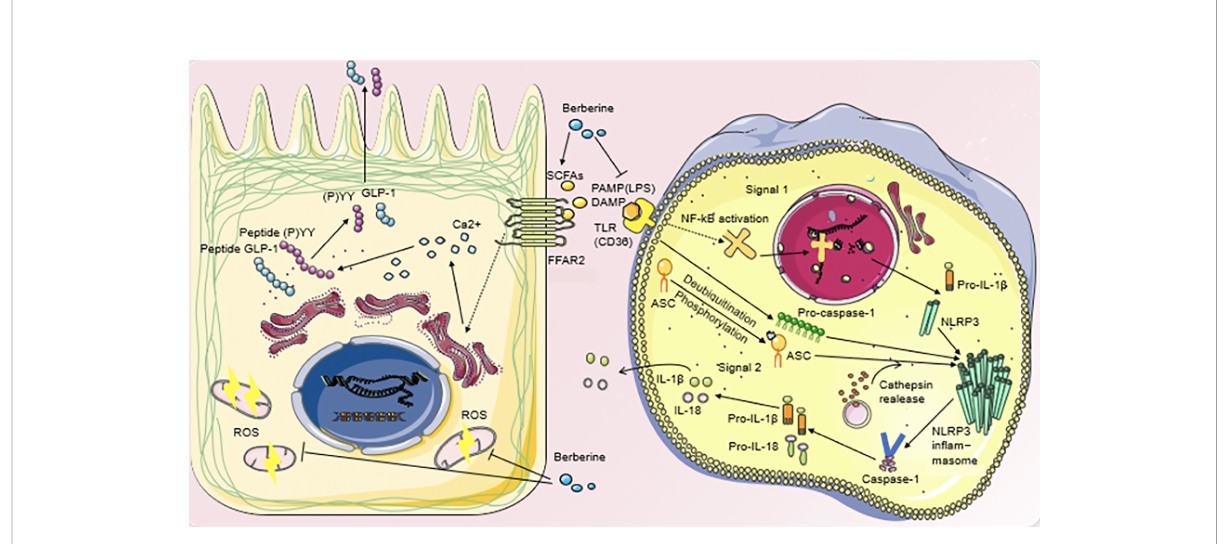
FIGURE 2 Regulatory mechanisms of BBR on metabolic